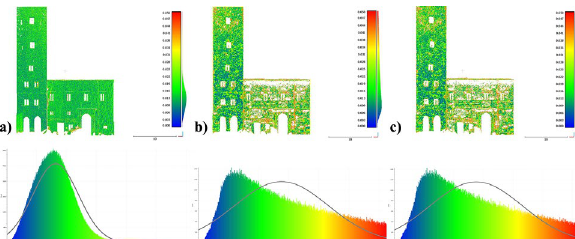
Figure 4: C2C analysis between point clouds: a) CAM2 Faro Focus X330 VS Leica BLK360; b) CAM2 Faro Focus X330 VS photogrammetric cloud by Sony alpha 6500; c) Leica BLK360 VS photogrammetric cloud by Sony alpha 6500